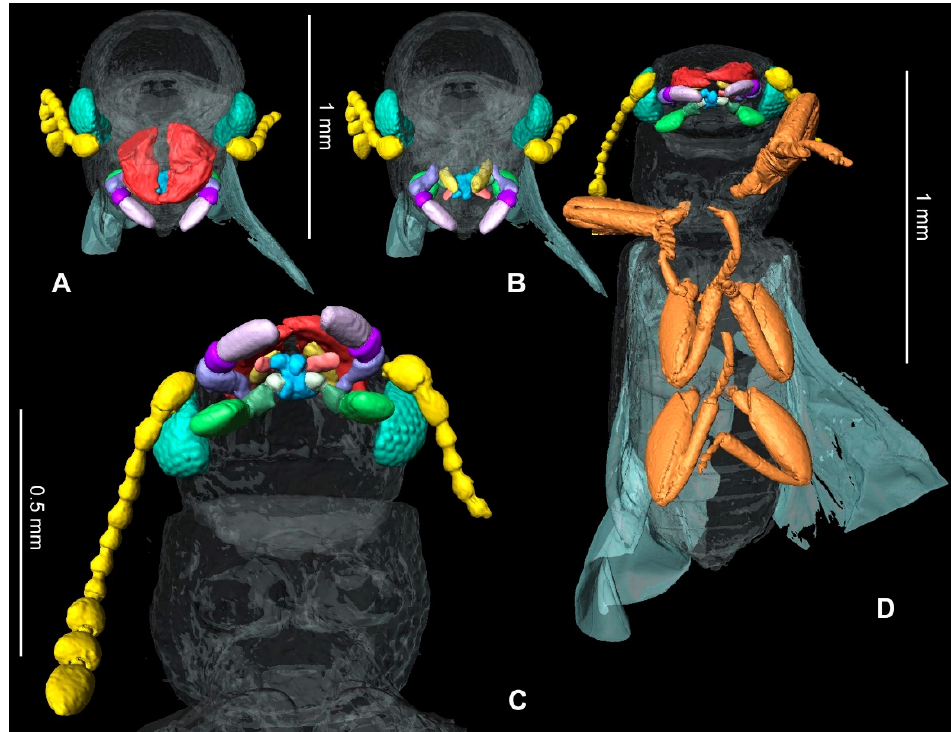
Figure 3. Detailed reconstruction of the eyes, antennae, mouthparts, and legs: ( A ) head anteriorly, including mandibles; ( B ) head anteriorly excluding mandibles; ( C ) head ventral view; ( D ) body ventrally with highlighted eyes, antennae, mouthparts and legs. ventrally with highlighted eyes, antennae, mouthparts and legs.